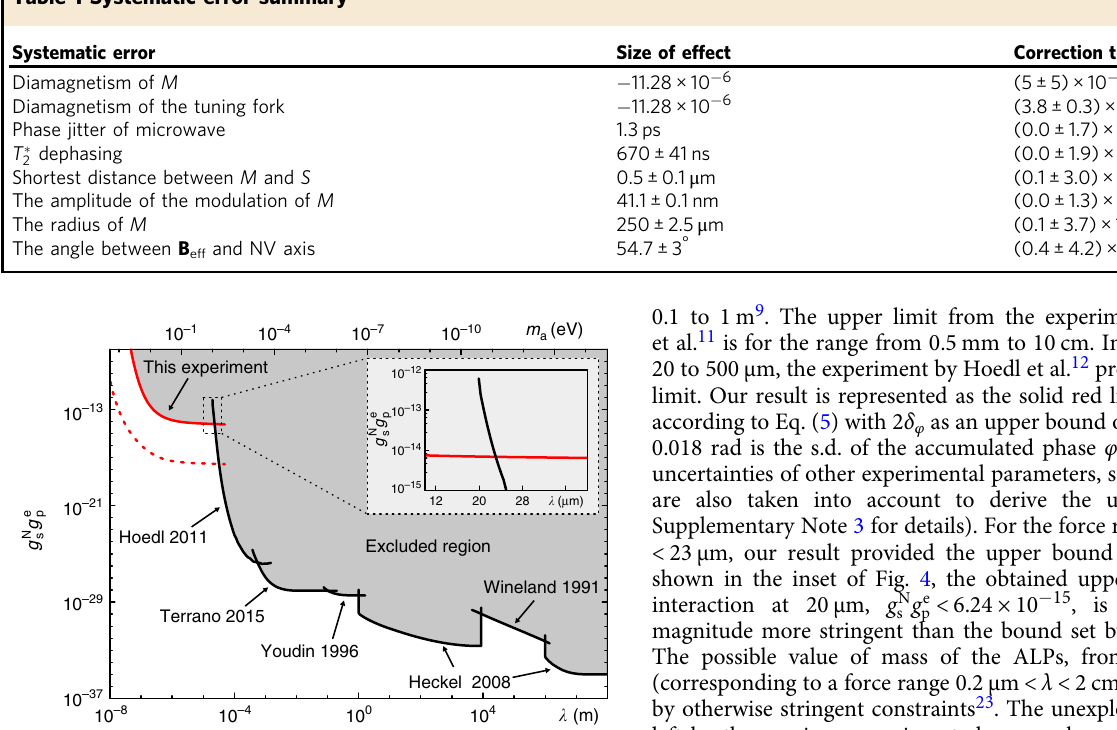
g e as a function of the force range λ and mass of Fig. 4 Upper limits on g N s p the axion-like particle m a . Our result is represented as the red solid line. The black solid lines represent the results from refs. 8 – 12 . The red dashed line shows the available improvement of the constraint on g N g e in future (see s p Supplementary Note 3 for details). The inset shows a comparison of our result and that from ref. 12 with the force range nearby 20 μ m, which illustrates an improvement of two orders more stringent for our result at 20 μ m compared with that from ref.